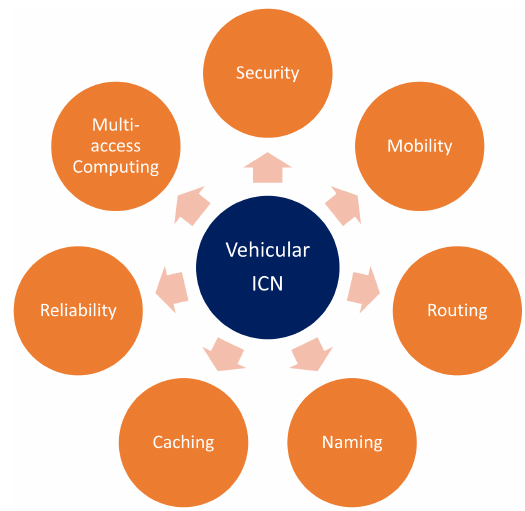
Figure 4. An example of research challenges faced by Vehicular